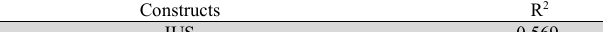
R 2 of the endogenous latent variables Constructs R 2